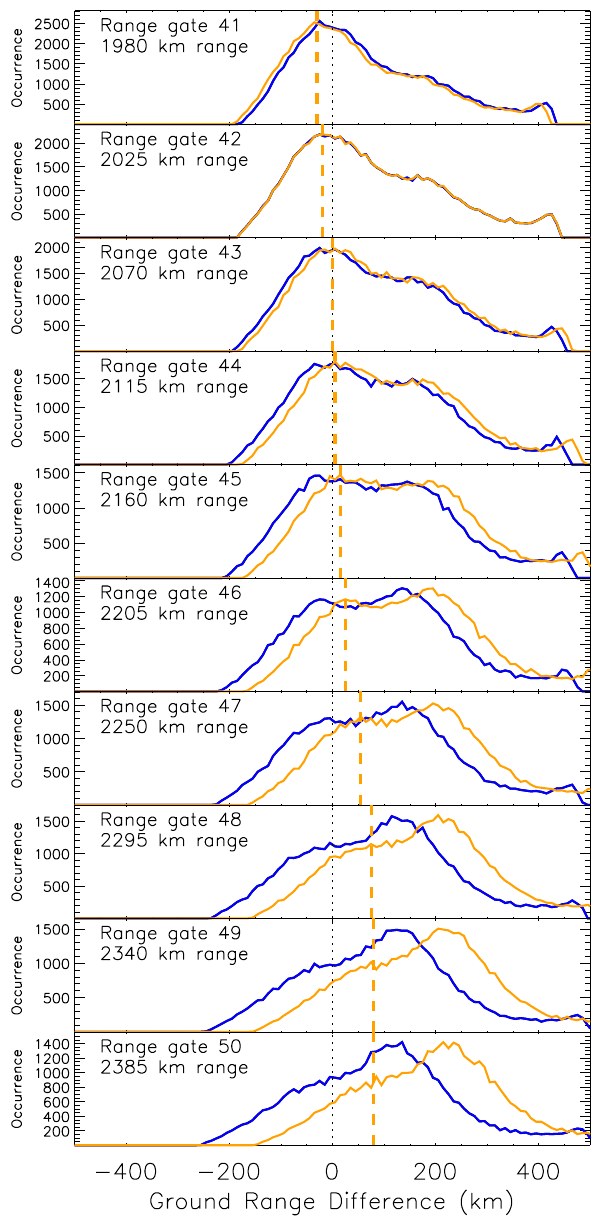
Fig. 15. Ground range difference distributions in the 1 1 1 -hop F-region overlap region comparing the performance of the 2 1 -hop F-region model (blue distributions) and the 1 1 2 model (yellow distributions) when the measured backscatter is as- sumed to be truly 1 -hop. The distributions are shown at every range 2 gate from range gate 41 (1980km range; top panel) to range gate 50 (2385km range; bottom panel). The vertical dashed yellow lines highlight the 1 -hop backscatter peak of the yellow 2